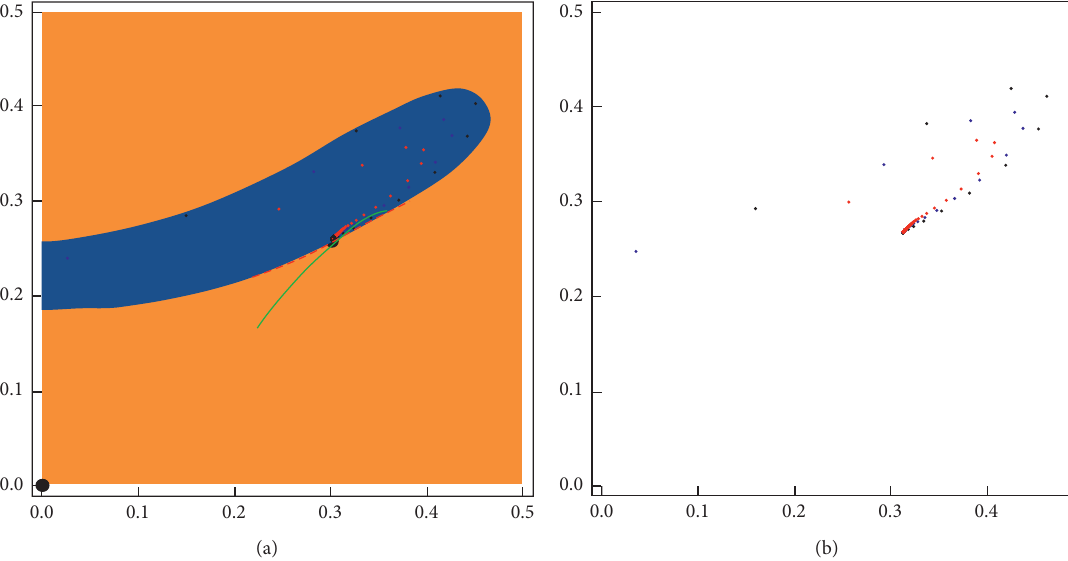
Figure 5: (a) The local approximation of the stable (red) and center manifold (green) of equation (1) in nonhyperbolic case, a � 1 and f � 1/8 � 0 . 125. (b) Trajectories of some solutions for a � 1 and f � 0 .